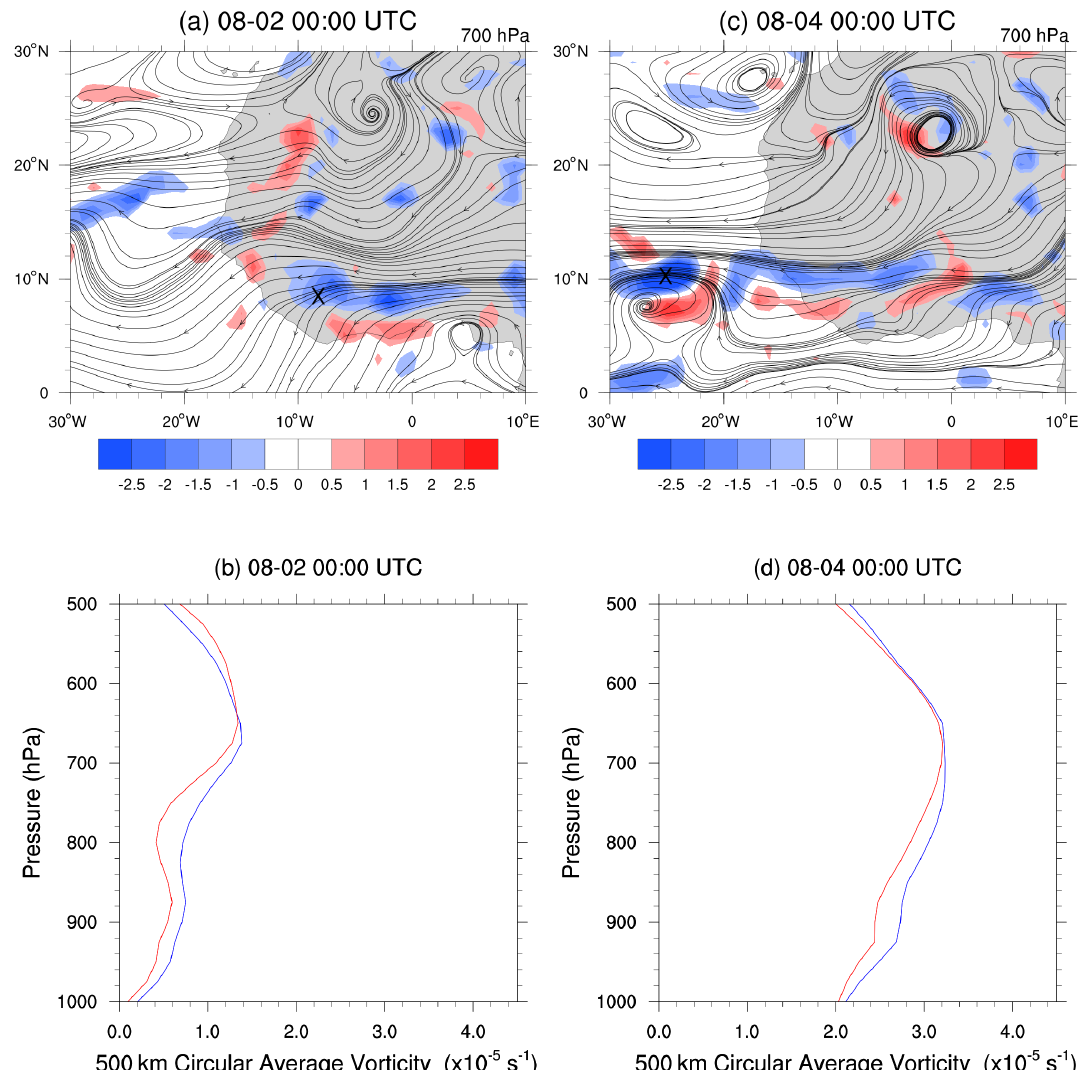
Figure 7. The evolution of the AEW associated with Gert on 2 August (a,b) and 4 August (c,d) . The top panels (a,c) show the 700hPa CTL streamlines (black) and the AER–CTL 700hPa cyclonic vorticity differences (red/blue); the cross (X) marks the wave’s location from the tracking algorithm. The bottom panels (b,d) show the circular average vorticity (radius 500km) taken at the crosses (X) for CTL (blue) and AER (red). Note that, for the dates in the panel headings, the first digit corresponds to the month and the second digit to the